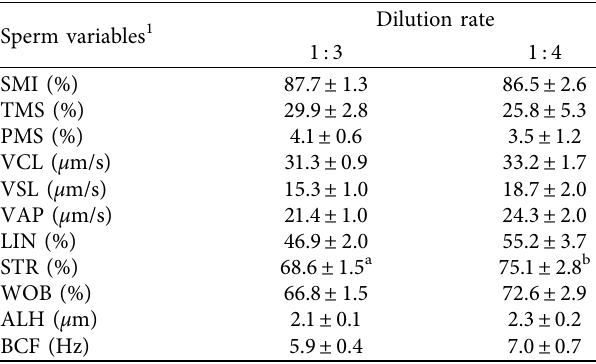
Table 5: Sperm viability and CASA parameters (LSMeans ± SE) measured in budgerigar semen samples diluted in 8.4 pH Lake extender (LE) at different rate before quality